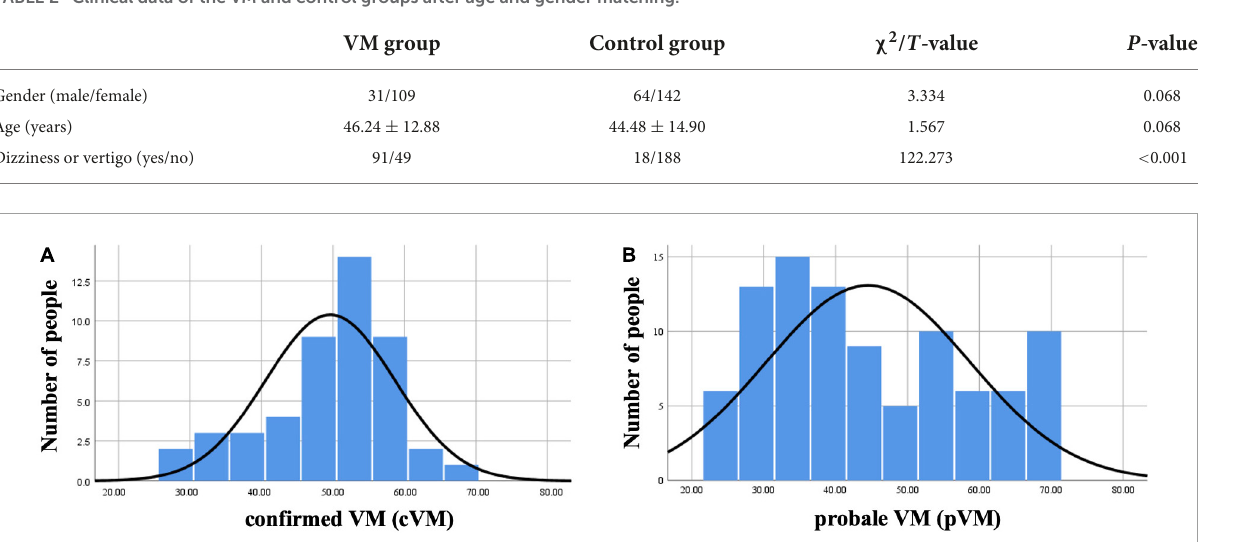
TABLE 2 Clinical data of the VM and control groups after age and gender matching.